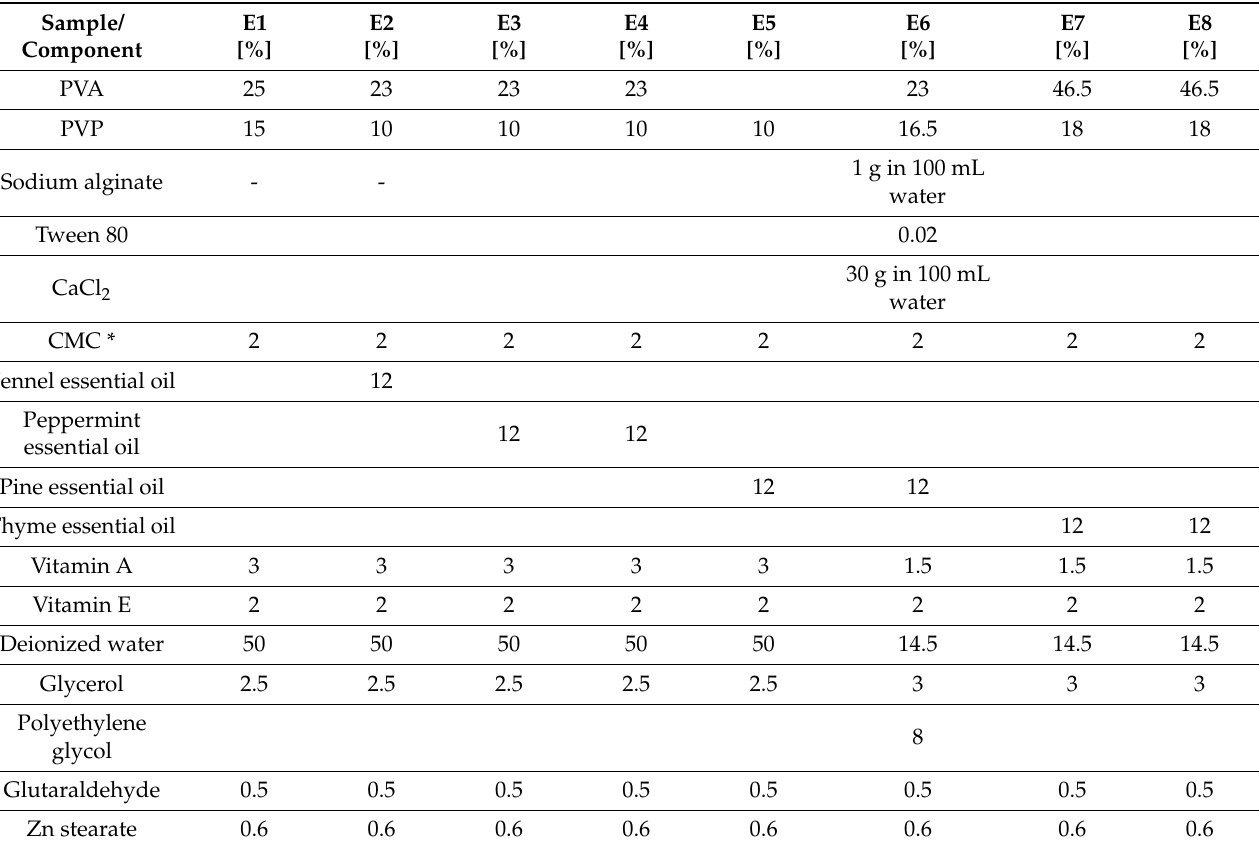
Table 4. Composition of the experimental matrices